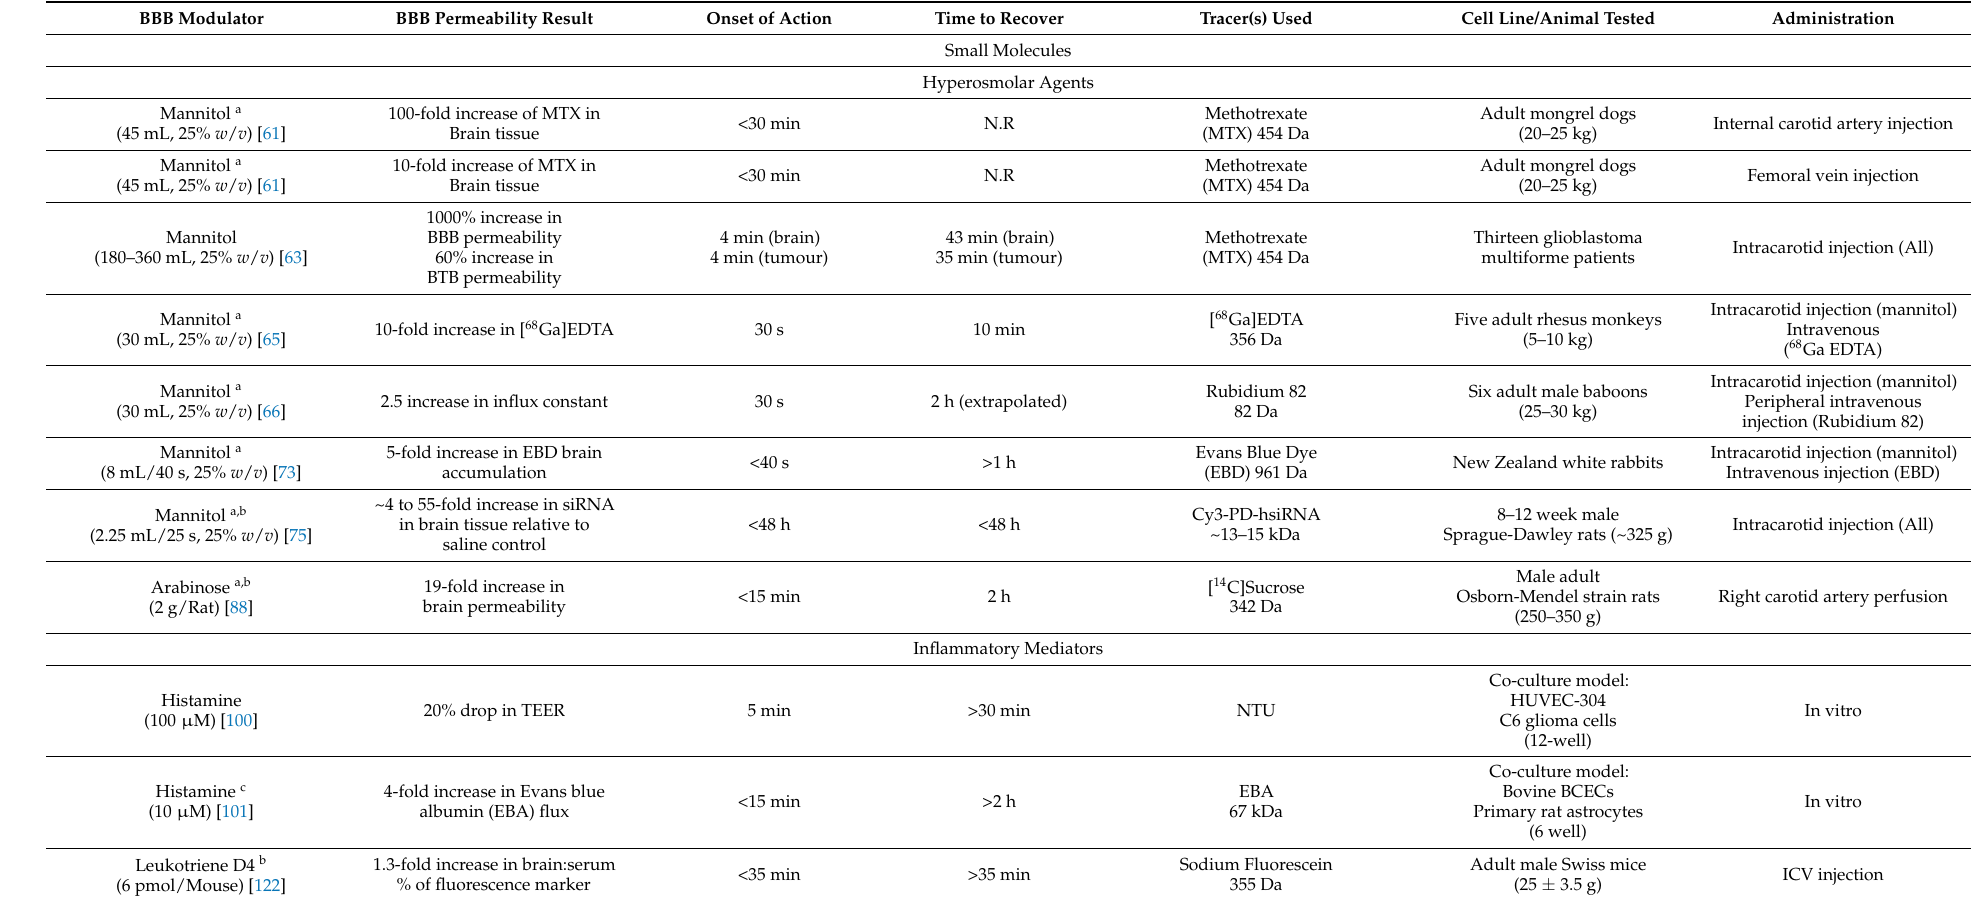
Table 3. Summary of BBB